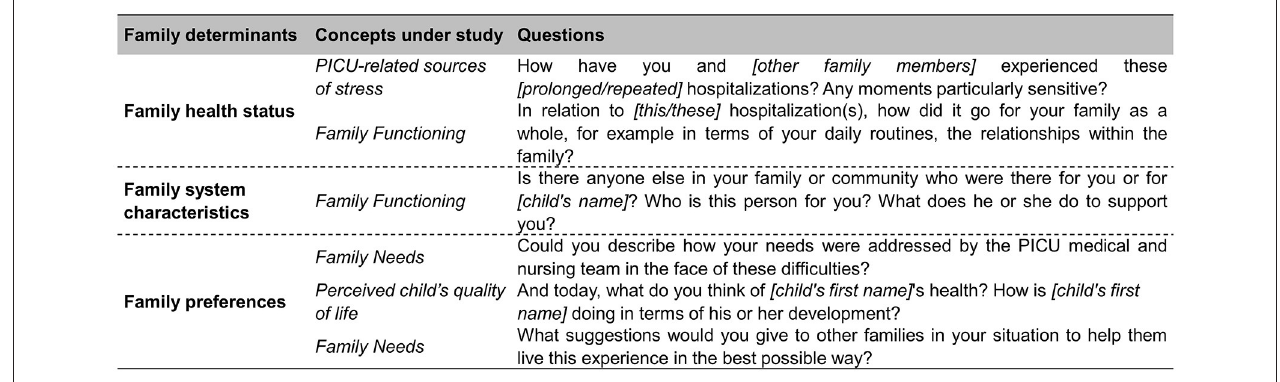
FIGURE 2 | Illustration of the development of the interview guide based on the family determinants (4, 22) and the concepts under study.